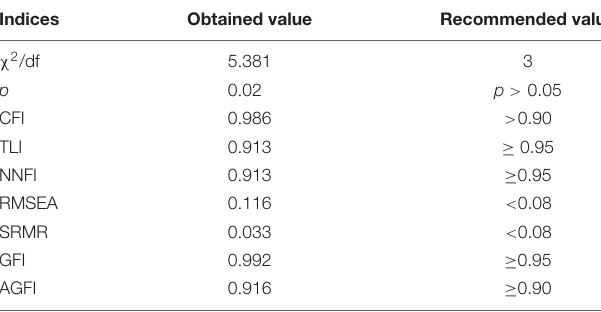
TABLE 6 | Fitness indices for mediation